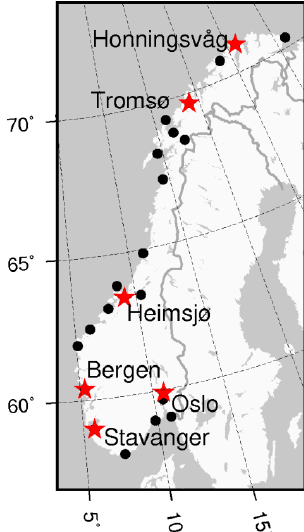
Figure 1. The 23 tide gauges that form the Norwegian tide gauge network. The red stars with names indicate the tide gauge sites chosen as key locations in this article (i.e., here we show sea-level projections and return periods for extreme sea levels).